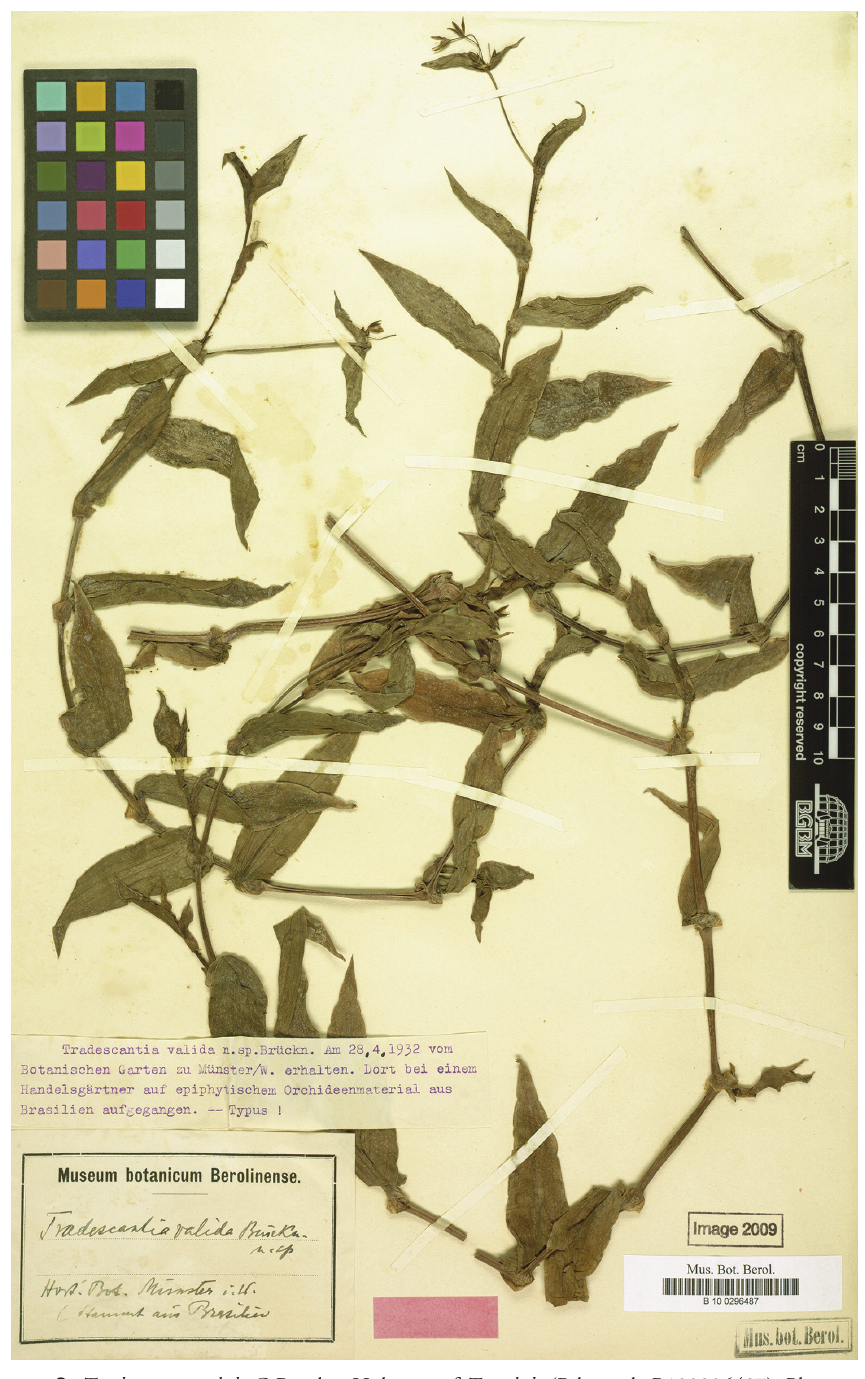
Figure 3. Tradescantia valida G.Brückn. Holotype of T. valida (B barcode B100296487). Photograph courtesy of the Botanic Garden and Botanical Museum Berlin-Dahlem, Freie Universität